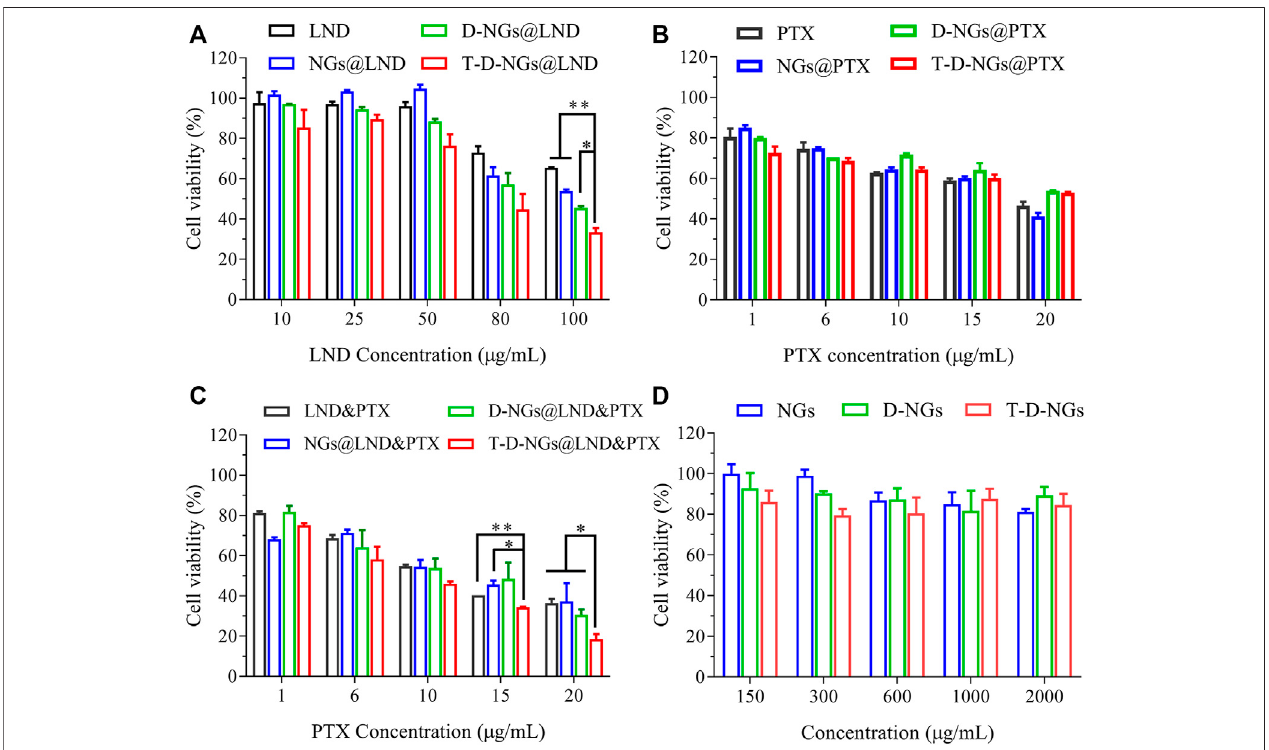
FIGURE 7 | Cytotoxicity of MCF-7/MDR cells after 48-h treatments of (A) LND-loaded nanogels, (B) PTX-loaded nanogels, (C) LND and PTX-loaded nanogels (LND: 50 μ g/ml), and (D) drug-free nanogels ( n (cid:2) 3, * p < 0.05, ** p < 0.01).